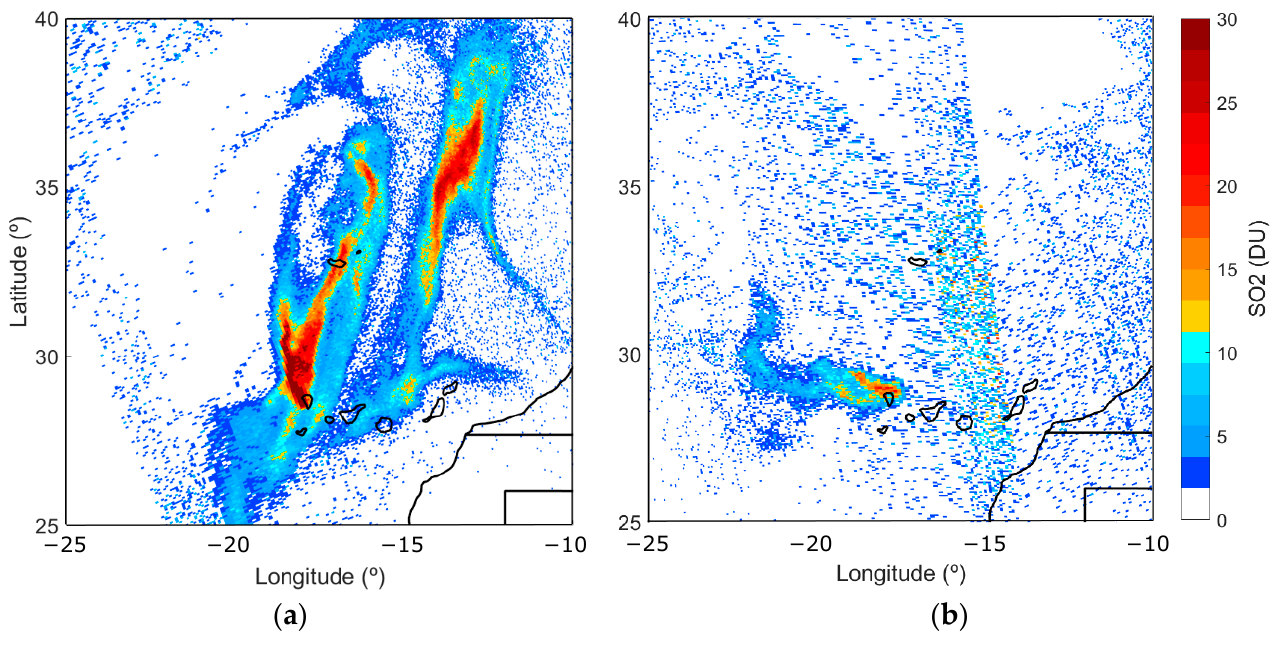
Figure 3. TROPOMI sulfur dioxide total vertical column (DU) over the Canary Islands on ( a ) 18 October and ( b ) 15 November 2021. Overpass time is about 13:30 local time.